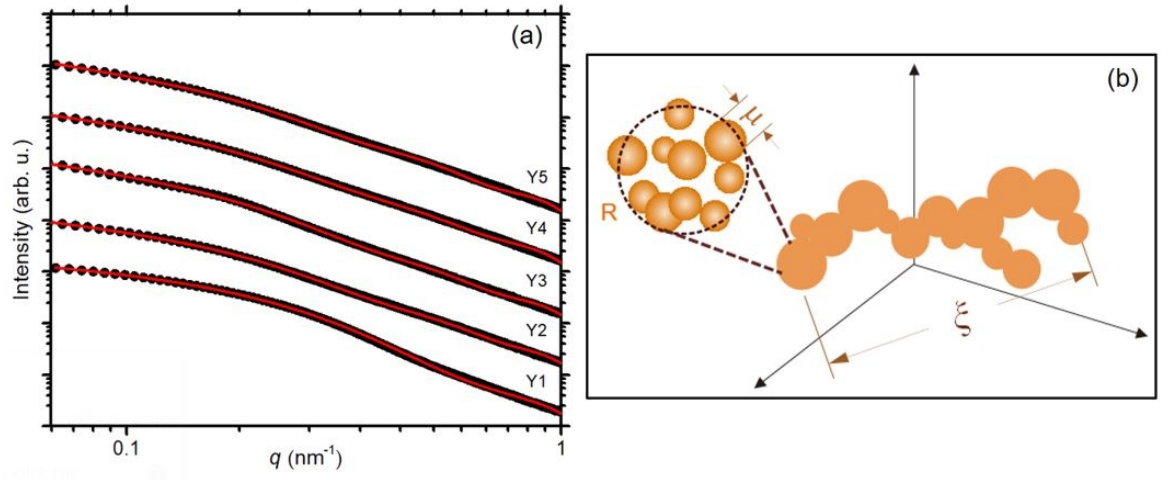
Figure 4. Synchrotron SAXS profiles of the Zn-doped magnetite ferrofluids (a); the black circles represent the experimental data, and solid red lines represent the fitting model. (b) Schematic of the three-dimensional structure of the Zn-doped magnetite